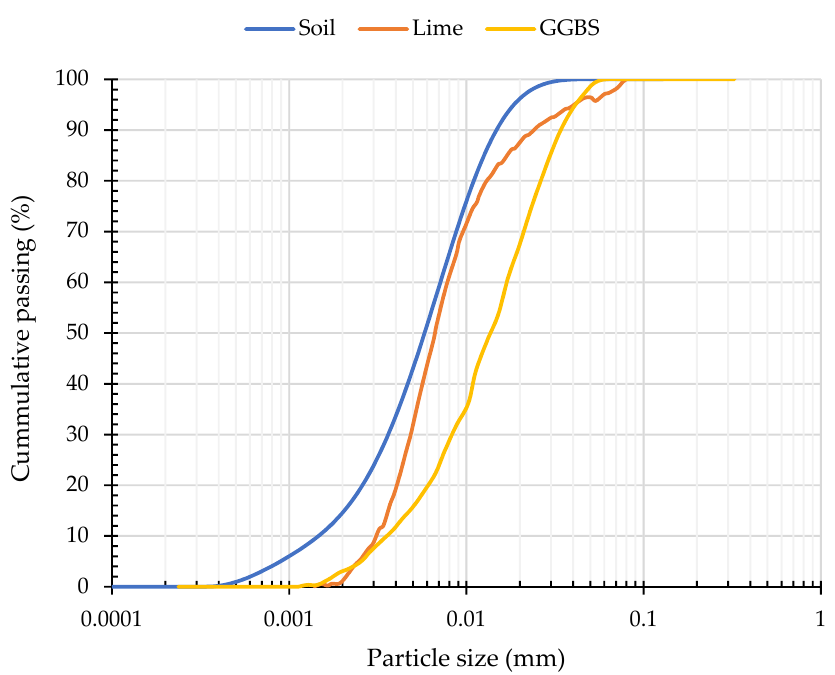
Figure 1. Particle size distribution of materials.